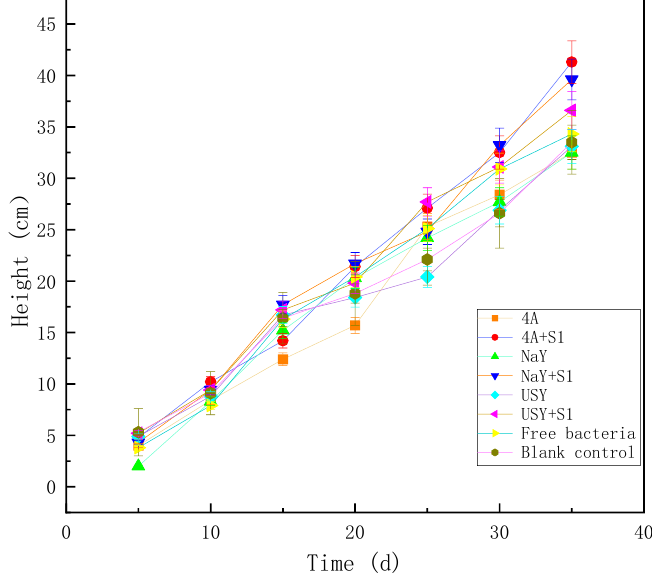
Figure 10. The effect of zeolite and bacteria on plant height.